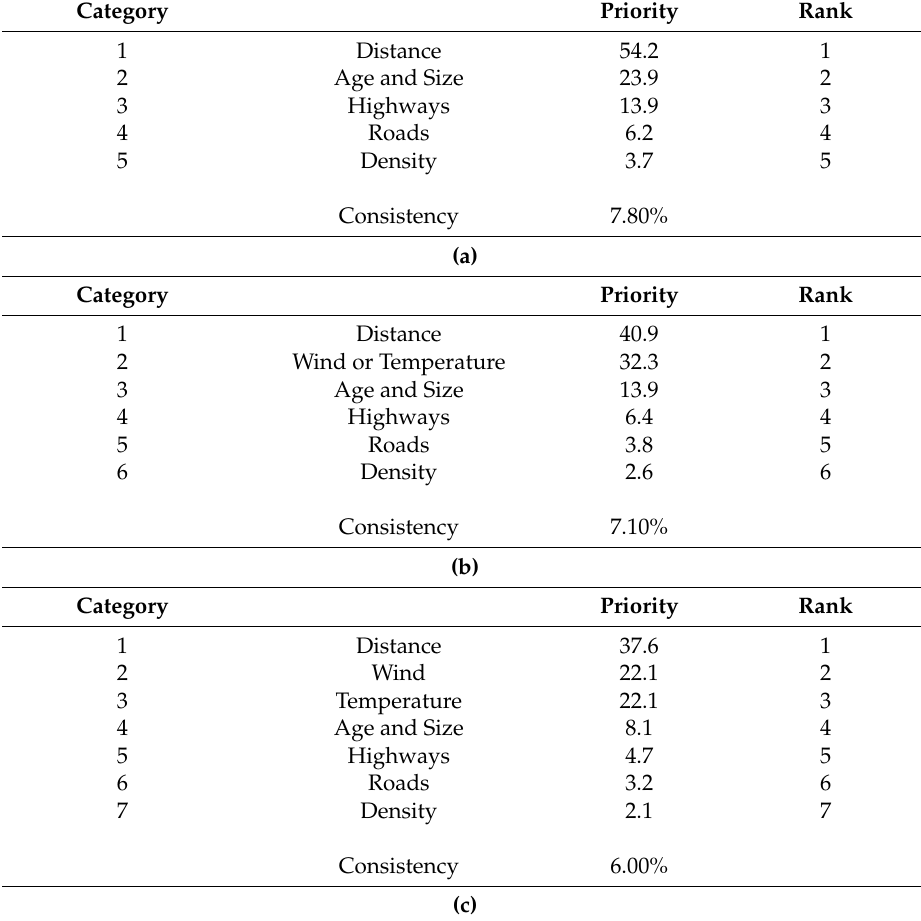
Table 1. The weights of the susceptibility factors that are used in the MCE component of the model without the influence of wind or temperature (a); including wind or temperature (b), and including both wind and temperature